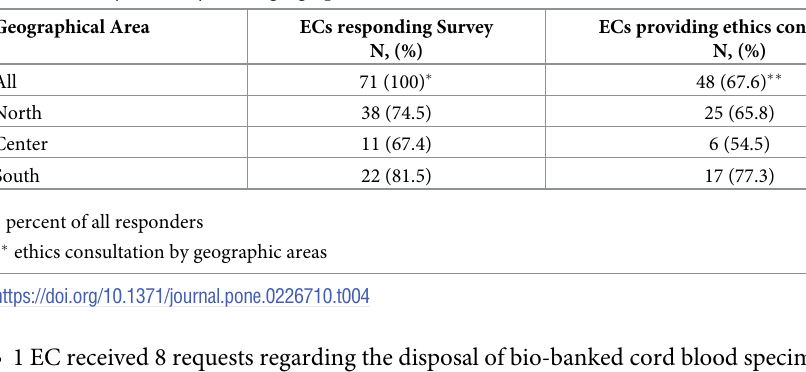
Table 4. Survey results by italian geographical